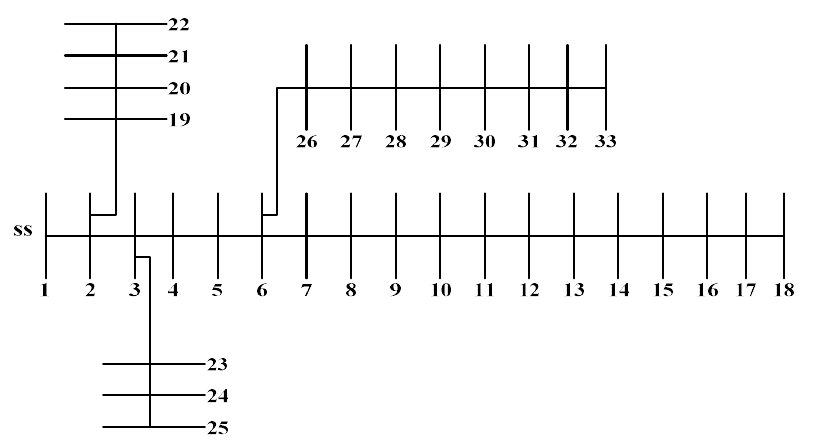
Figure 2. IEEE 33-bus with its single line diagram.